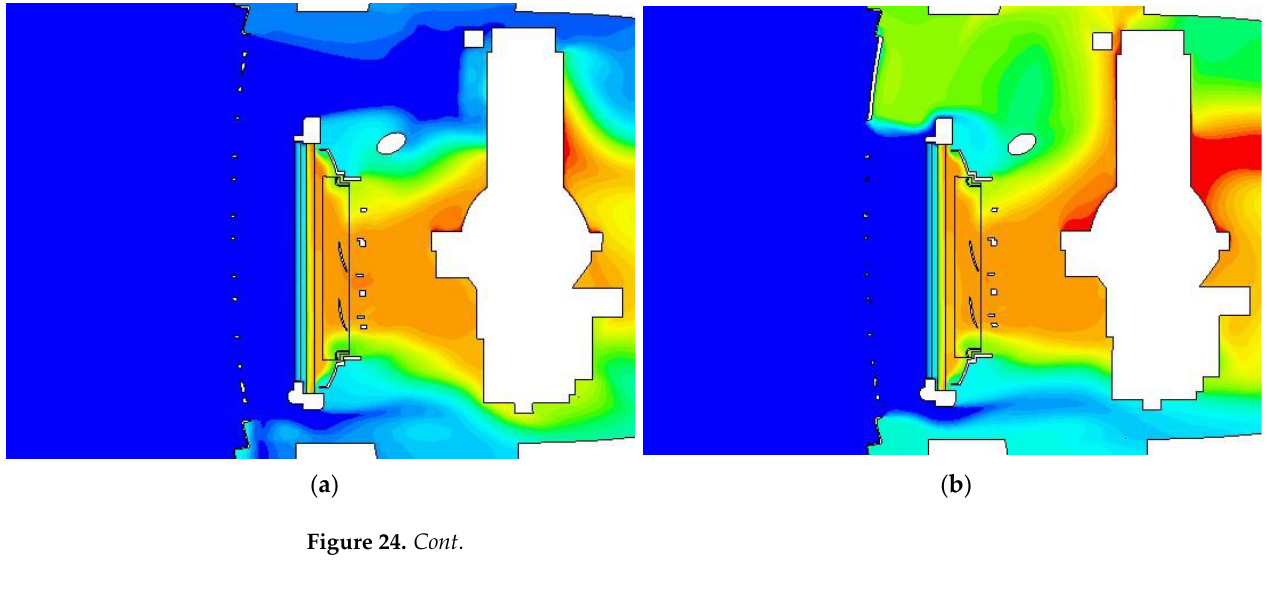
Figure 23. Comparisons of the radiator air inlet temperature under different schemes.